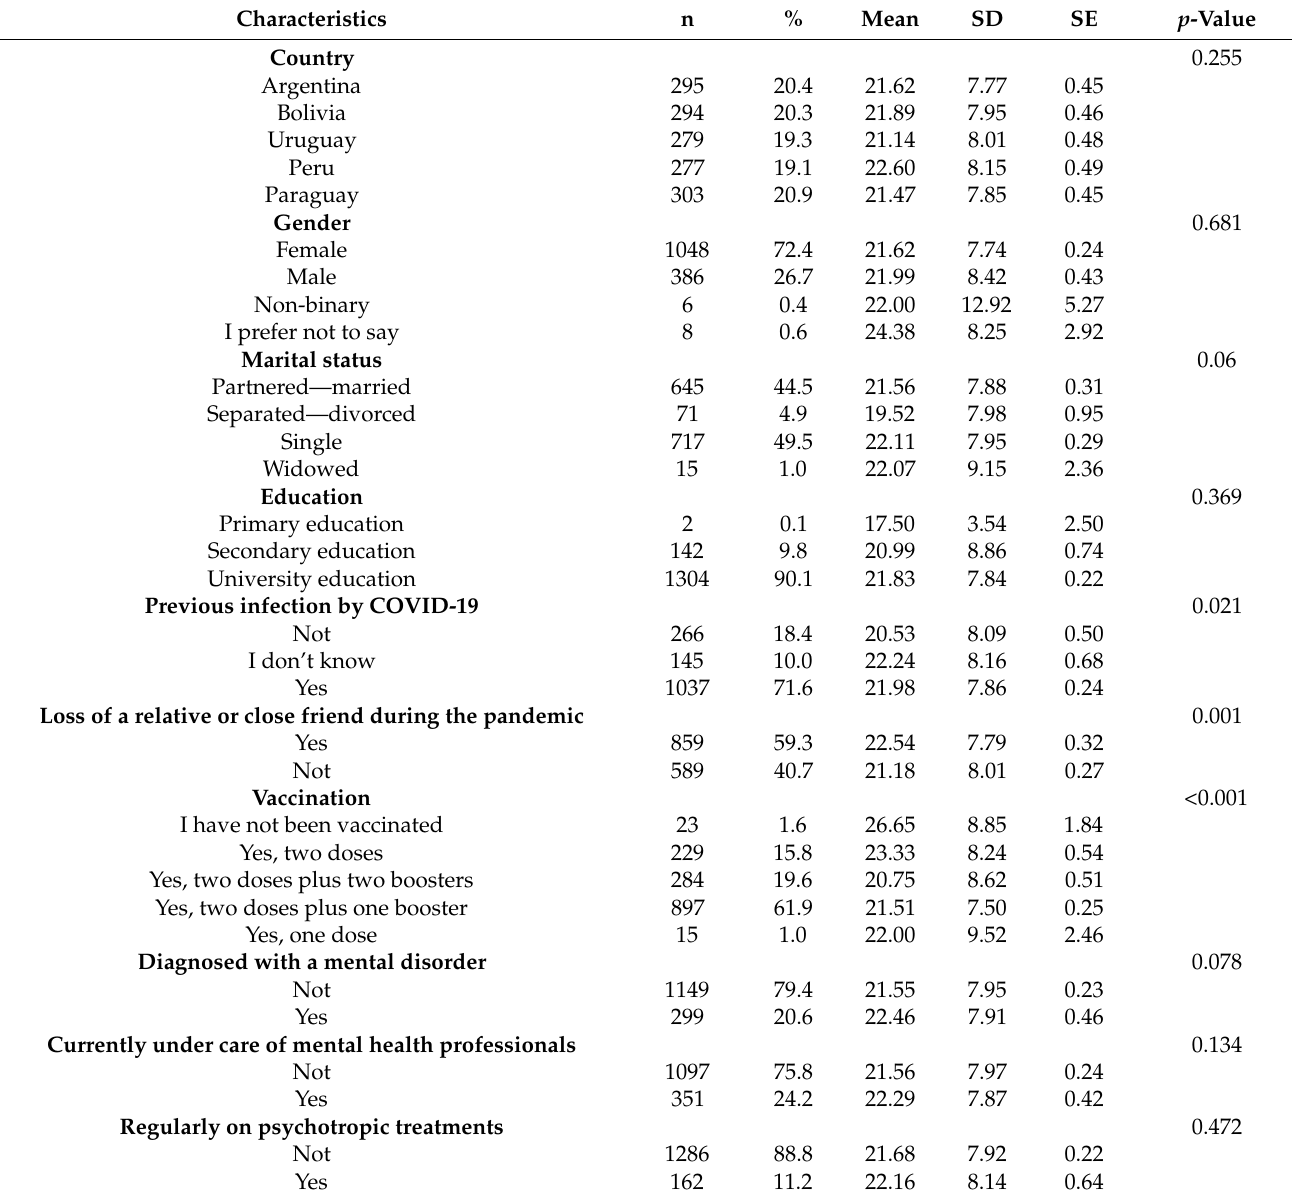
Table 1. Associated characteristics to the Pandemic Fatigue Scale (PFS scores) among respondents from South America (N =